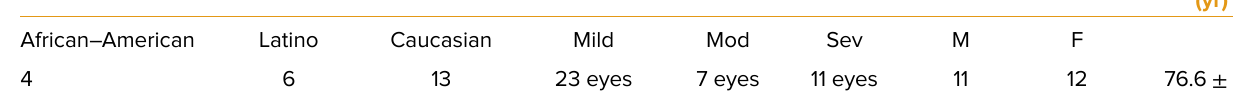
Table 1. Patient demographics